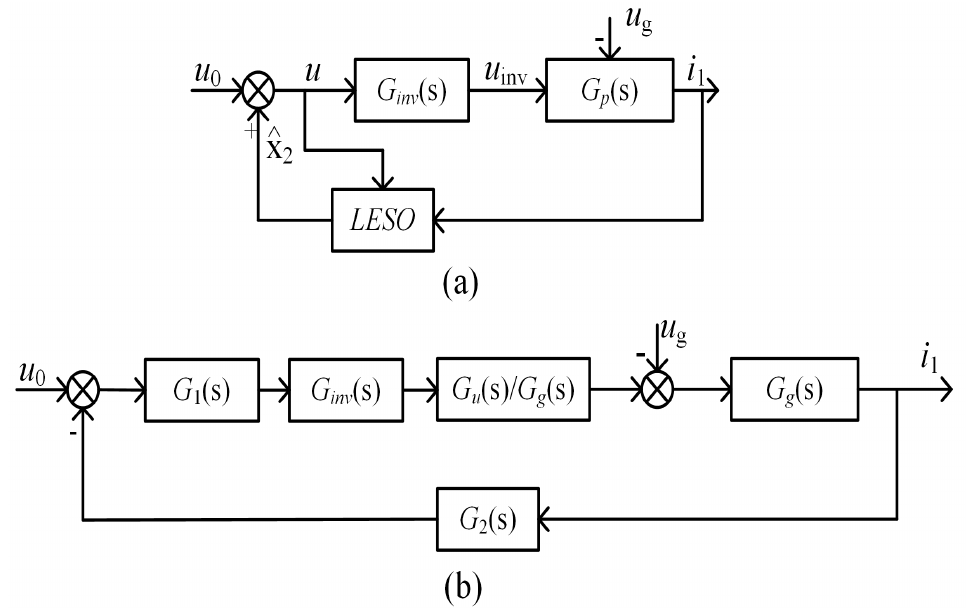
Figure 3. System control block diagram: ( a ) LESO disturbance compensation control; ( b ) equ- ivalent